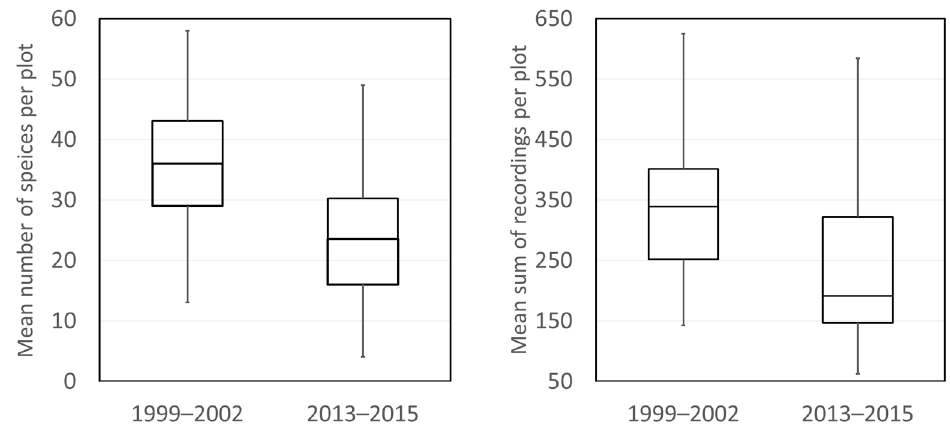
Figure 3. Change in the species occurrence and abundance between the observation campaigns (1999–2002; 2013–2015) at sample plots.